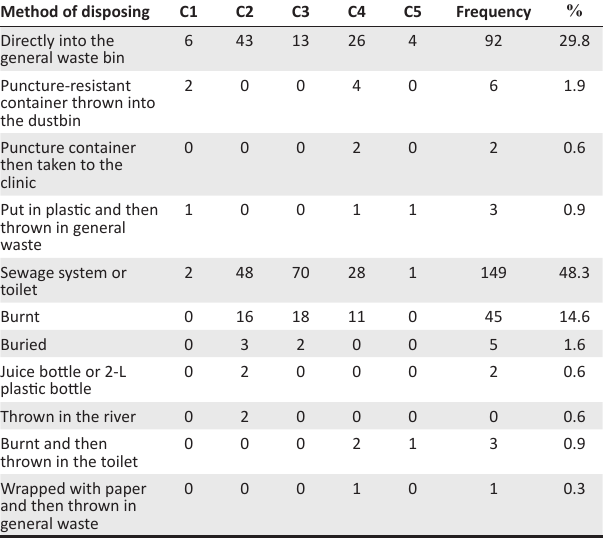
TABLE 2: Method of disposing sharps waste by respondents from all facilities. Method of disposing